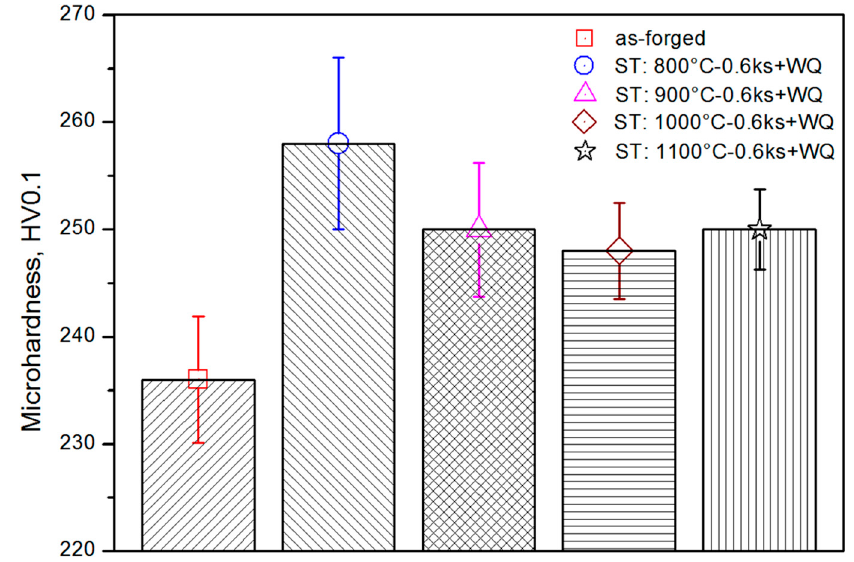
Figure 9. Global microhardness evolution for all investigated microstructural states.